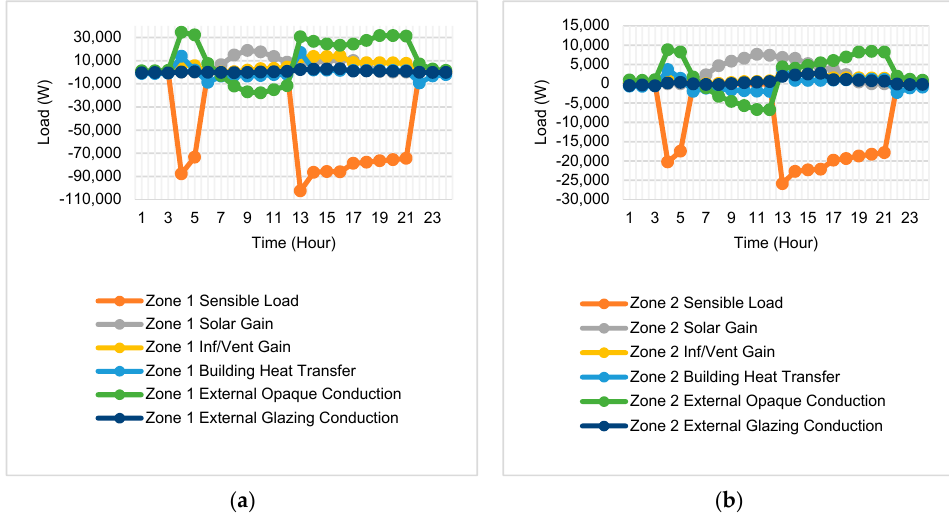
Figure 13. ( a ) Loads breakdown in Hudhayfah mosque (Zone 1) during day 179 (summer); ( b ) loads breakdown in Hudhayfah mosque (Zone 2) during day 179 (summer).